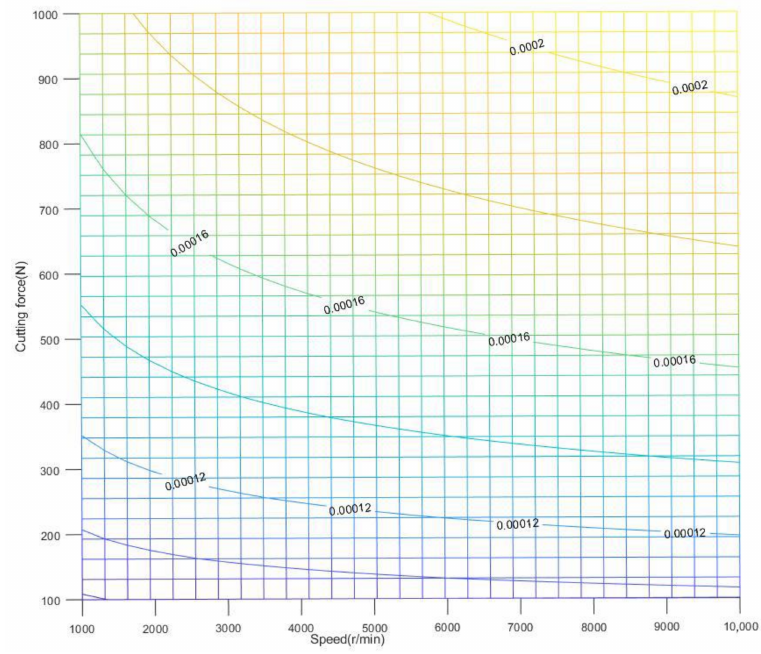
Figure 7. Stress contour of the